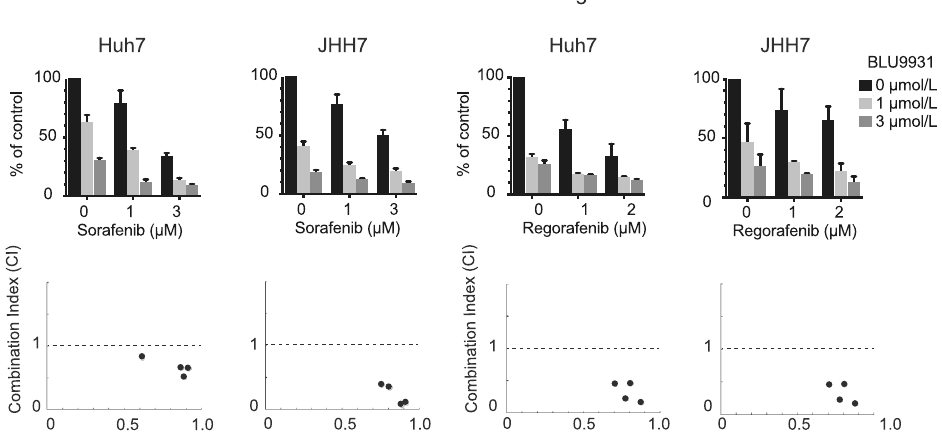
satellite nodules was significantly shorter than that in patients without vascular invasion and tumor satellite nodules in this cohort (592 days vs. 1725 days, p = 0.006). In FGF19 + FGFR4 + HCC and FGF19 − FGFR4 − HCC groups, 39.4% and 23.1% of patients had vascular invasion or tumor satellite nodules, respectively. There was